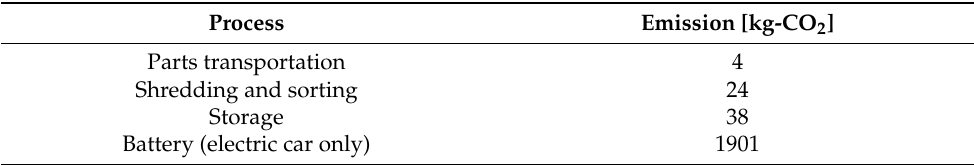
Table 4. CO 2 emissions for the utilization processes of vehicles.